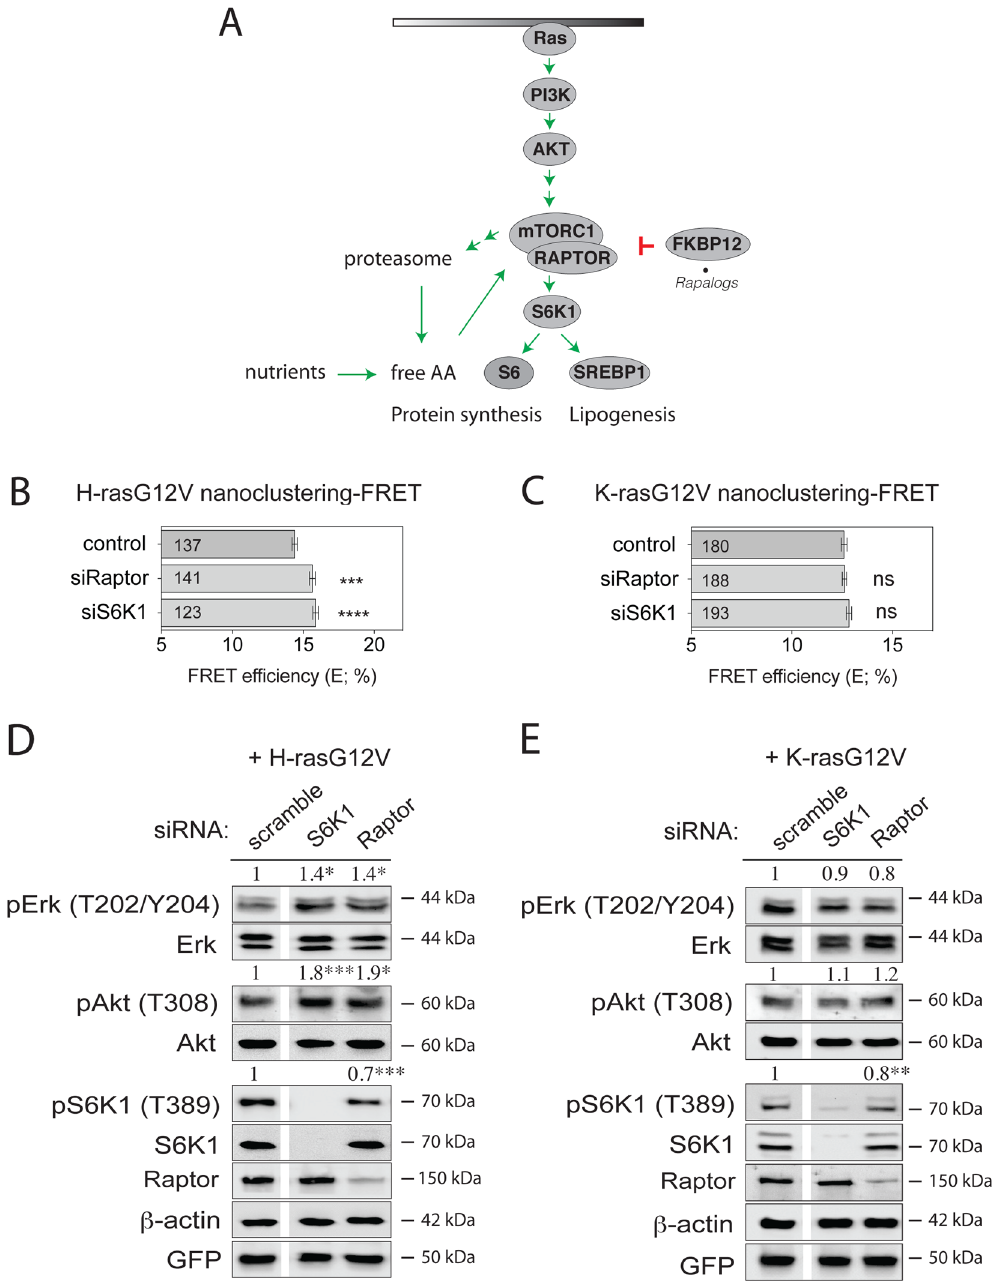
Figure 4. The ablation of mTORC1 pathway components Raptor and S6K1 increases specifically H-ras activity. ( A ) Schematic illustration of the basic mTORC1-signalling pathway and its relation to Ras output. We focused on proteins, whose expression levels were manipulated in this study. ( B , C ) Nanoclustering-FRET analysis in HEK cells transfected with scrambled siRNA or siRNA directed to Raptor or S6K1, and co-expressing mGFP- and mCherry-tagged ( B ) H-rasG12V or ( C ) K-rasG12V. The numbers in the bars indicate the number of analyzed cells (mean ± SEM, n = 4). ( D , E ) Western blot analysis of Ras- and mTORC1-signalling in HEK cells transfected with the indicated siRNA, and expressing ( D ) mGFP-H-rasG12V or ( E ) mGFP-K-rasG12V. Numbers indicate the ratio of phosphorylated to respective total protein levels (n = 3). Statistical significance levels are annotated as ns, not significant; * p < 0.05; ** p < 0.01; *** p < 0.001; **** p <